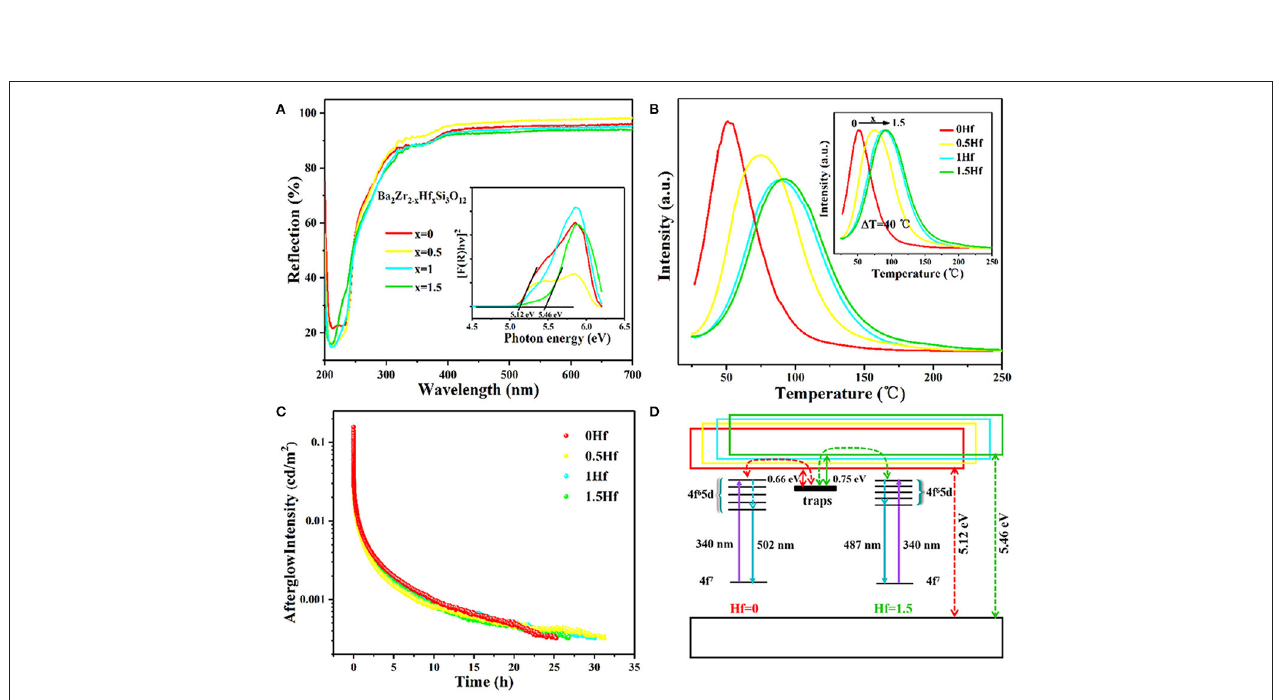
FIGURE 3 | (A) Diffuse reflectance spectra and Tauc plots (inset) of Ba 2 Zr 2 − x Hf x Si 3 O 12 ( x = 0, 0.5, 1, 1.5) samples. (B) The TL spectra, (C) LPL decay curves, and (D) Schematic energy level diagrams of Ba 2 Zr 2 − x Hf x Si 3 O 12 : 0.01Eu 2 + , 0.01Nd 3 + ( x = 0, 0.5, 1, 1.5). Reprinted with permission from Guo et al. (2019). Copyright (2019) American Chemical